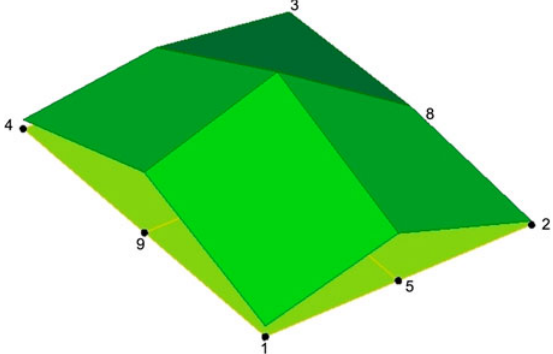
Fig. 17. Identified eigenshape for the fundamental eigen- frequency (9.27